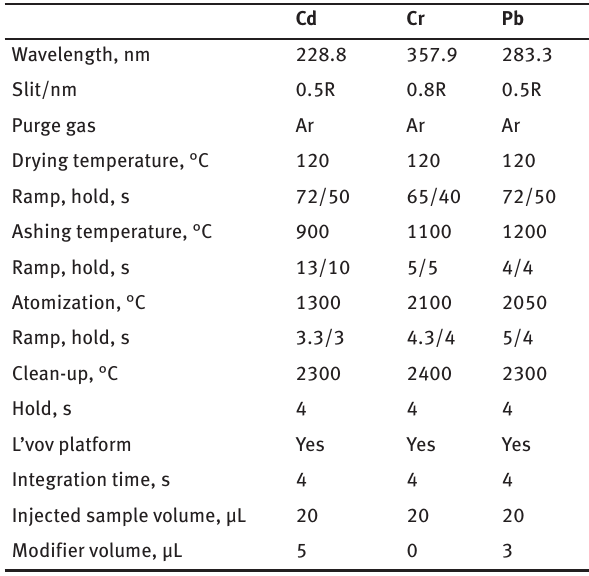
Table 1: Physical properties of ETAAS for the determination of Cd and Pb in tea